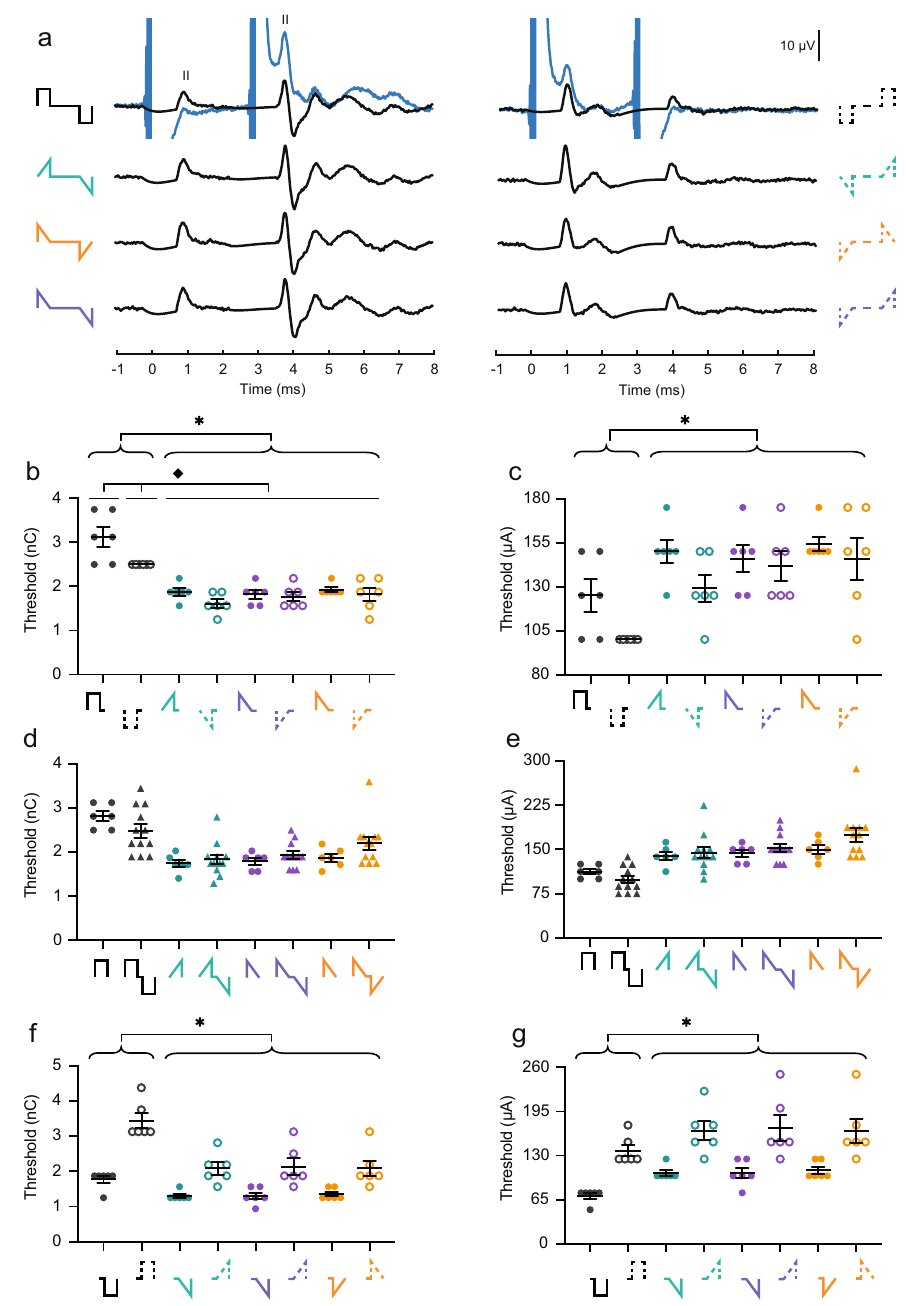
Figure 5. The effect with ramped pulses is not due to an “extra” interphase gap but rather to the ramp itself. ( a ) Example eABR traces to (left) Rec-A, rampUP-A, rampDOWN-A, rampLONG-A and (right) Rec-C, rampUP-C, rampDOWN-C, rampLONG-C with an interpulse gap of 2.9 ms. The amount charge injected was 3.6 nC for rectangular pulses and 2.5 nC for ramped pulses. The raw trace before removal of the exponential trend (blue line) is shown for Rec-A and Rec-C. Data from Mouse M15. ( b,c ) Thresholds of wave II evoked by the first, monophasic phase in ( b ) charge and ( c ) amplitude current level. Pulse shapes are shown below the x-axis. Each circle is data from one mouse. Closed circles, anodic-first pulses; open circles, cathodic-first pulses. ( d,e ) Thresholds of wave II evoked by the first, monophasic wave (circles) and by the biphasic pulse with an interpulse gap of 10 µ s (triangle, replotted from Fig. 3b) in ( d ) charge and ( e ) amplitude current level. Both conditions were averaged across polarity. Only anodic-first shapes are shown below the x-axis for simplicity. ( f,g ) Thresholds of wave II evoked by the second, monophasic phase in ( f ) charge and ( g ) amplitude current level. Asterisk and diamond denote significant effect in post-hoc test of the factor pulse shape and the pulse shape * polarity interaction (Tukey HSD), respectively. * p ≤ 0.05; ♦ p ≤ 0.05. n = 6. Error bars are